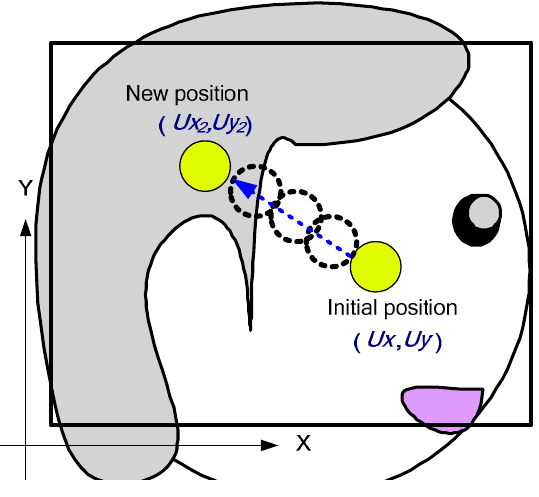
Figure 2. The dynamic image search method.